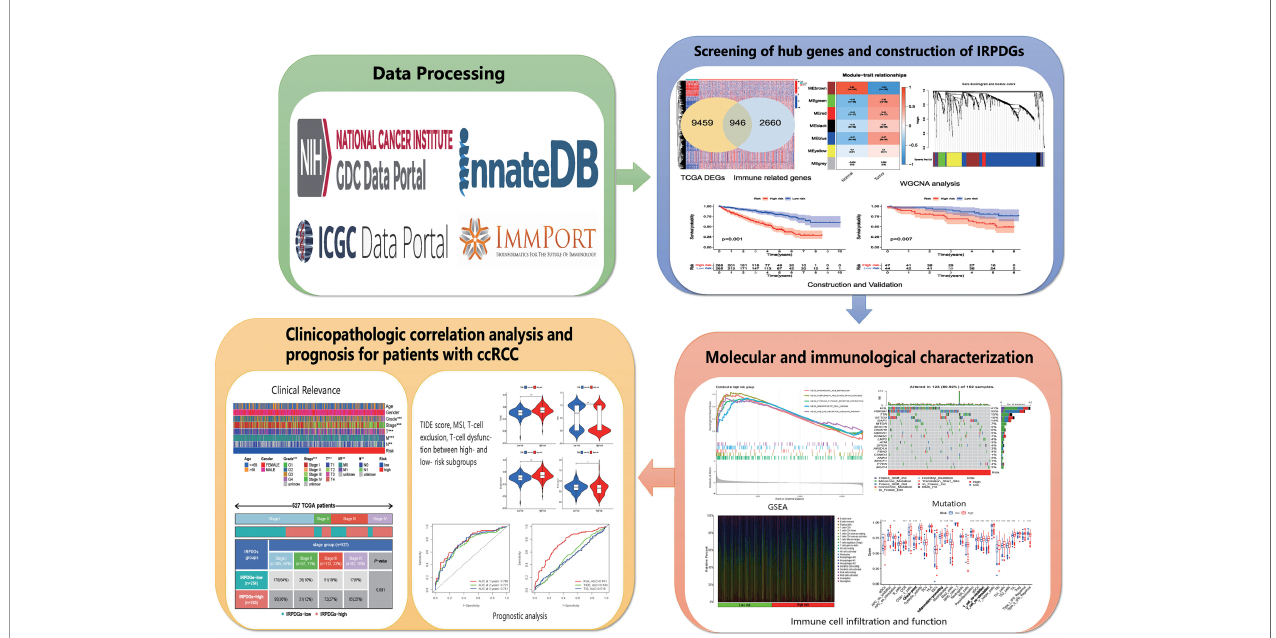
FIGURE 1 | Work fl ow of the